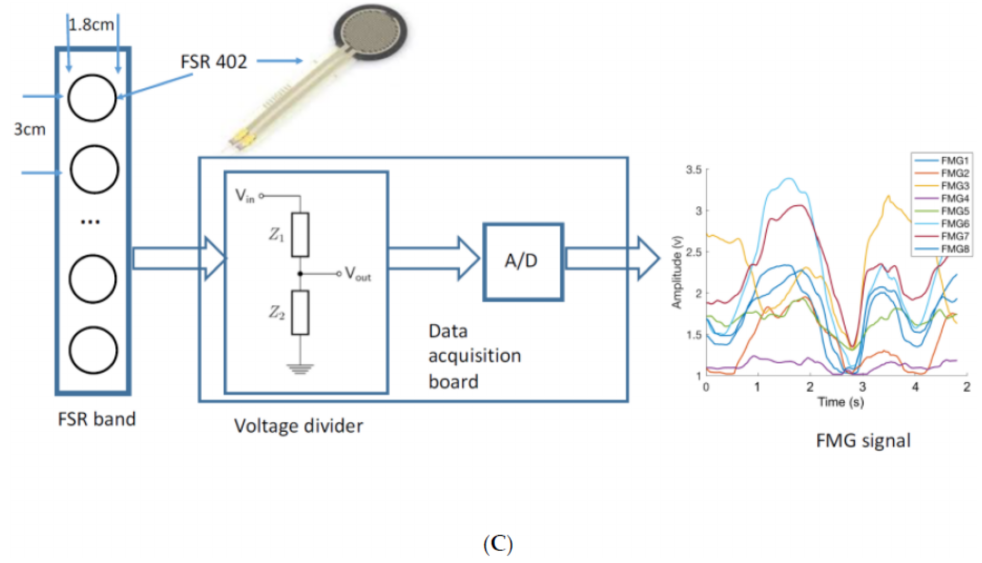
Figure 1. The experimental setup: ( A ) Schematic of the cross section of the ankle showing the main muscles and the location of force-sensing resistor (FSR) sensors (TA: Tibialias Anterior, EDL: Extensor Digitorum Longus, EHL: Extensor Hallucis Longus, Tib: Tibia, FL: Fibularis Longus, FB: Fibularis Brevis, Fib: Fibula, TP: Tibialis Posterior, FDL: Flexor Digitorum Longus, FHL: Flexor Hallucis Longus); ( B ) The force myography (FMG) ankle band is worn on the ankle of the dominant foot while the participant walks on a treadmill with a high speed camera recording the trial session; ( C ) The acquisition and conversion of the FMG